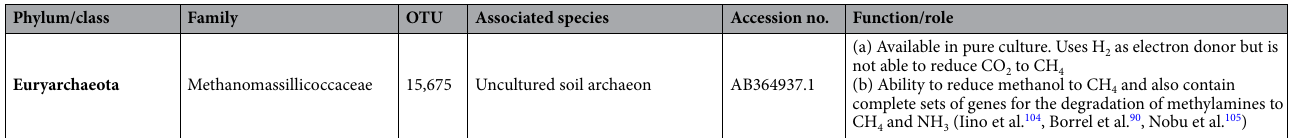
Table 3. Compilation of major operational taxonomic units (OTUs) from each family, their associated identity and potential function/role in carbon cycling. No information (ND) was found for most of the OTUs that are associated with uncultured bacterium/archaeon.